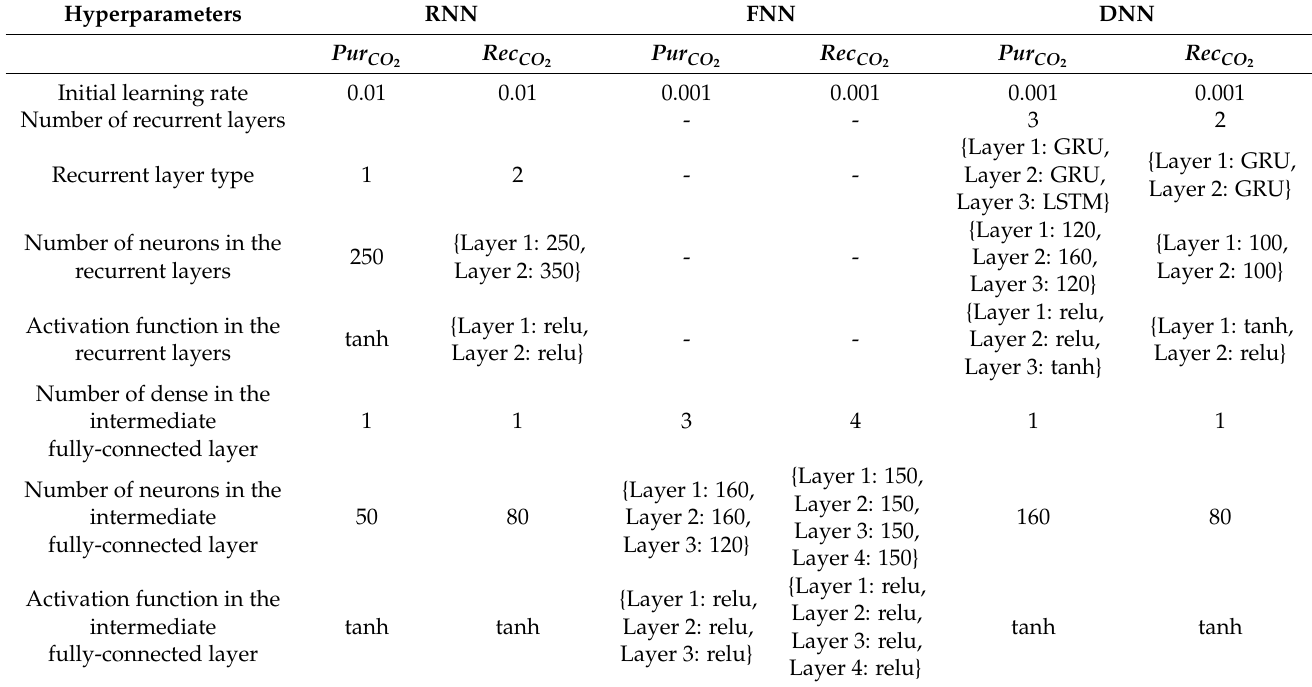
Table 2. Results of best hyperparameters for each performance indicator for RNN, FNN and